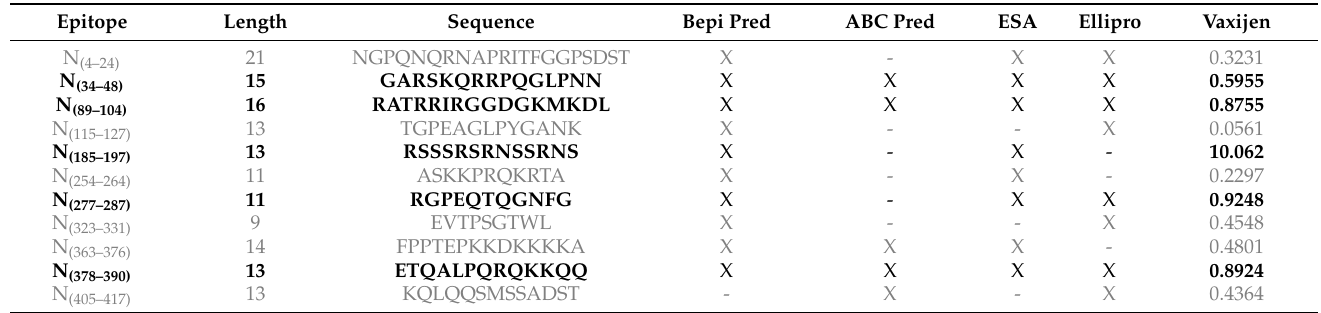
Table 1. Evaluation of potential serological targets in SARS-CoV-2 N protein.